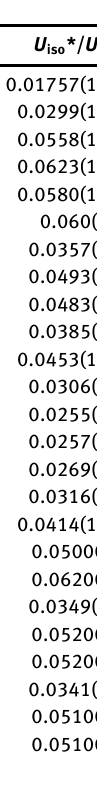
Table 2: Fractional atomic coordinates and isotropic or equivalent isotropic displacement parameters (Å 2